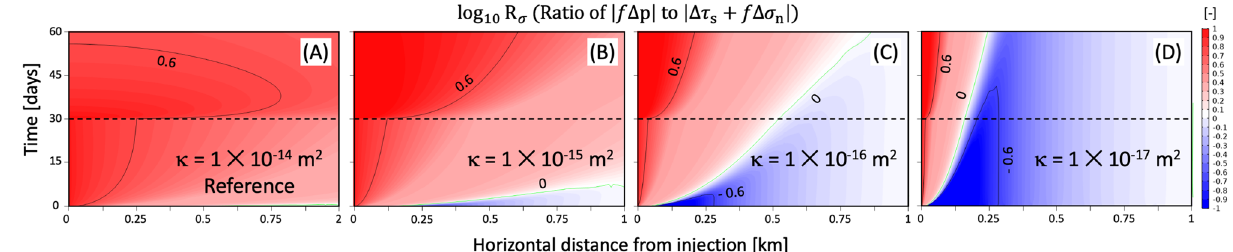
Figure 1. Spatio-temporal distribution of log 10 R σ along the horizontal line of the 2-D model domain (red line in Figure S1A) with variation in the formation permeability ( κ �τ s f �σ n , such that diffusion and poroelastic stressing contribute equally to log R σ 0 represents f � p 10 = + = total changes in Coulomb